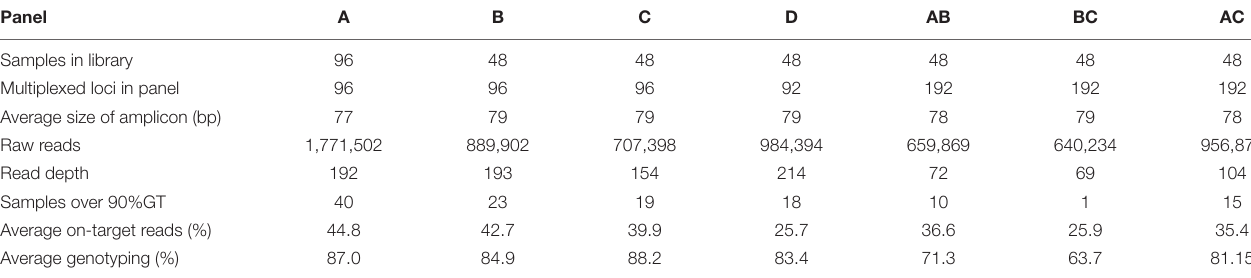
Read depth = Reads/(Loci × Samples).